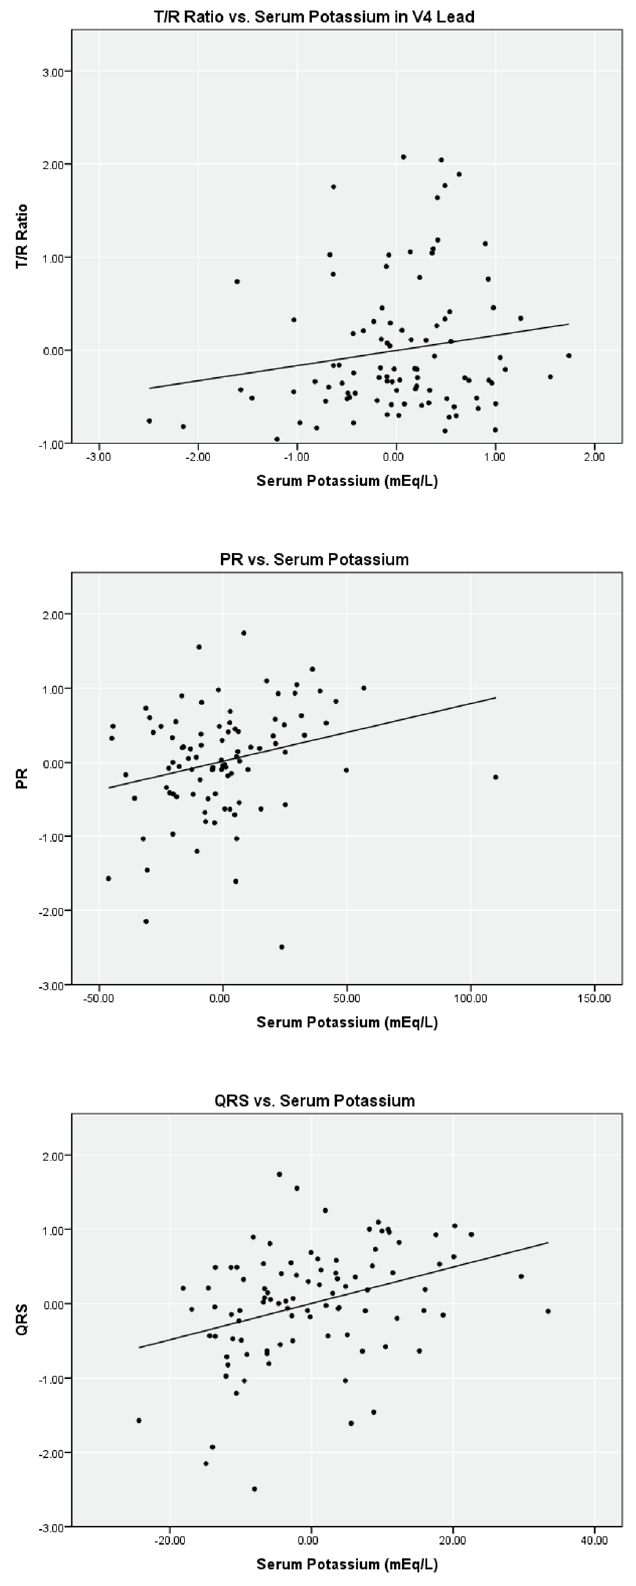
Figure 1. Partial linear correlation of serum potassium versus ECG parameters while controlling for ionized calcium and bicarbonate on limited data set ( n = 96).